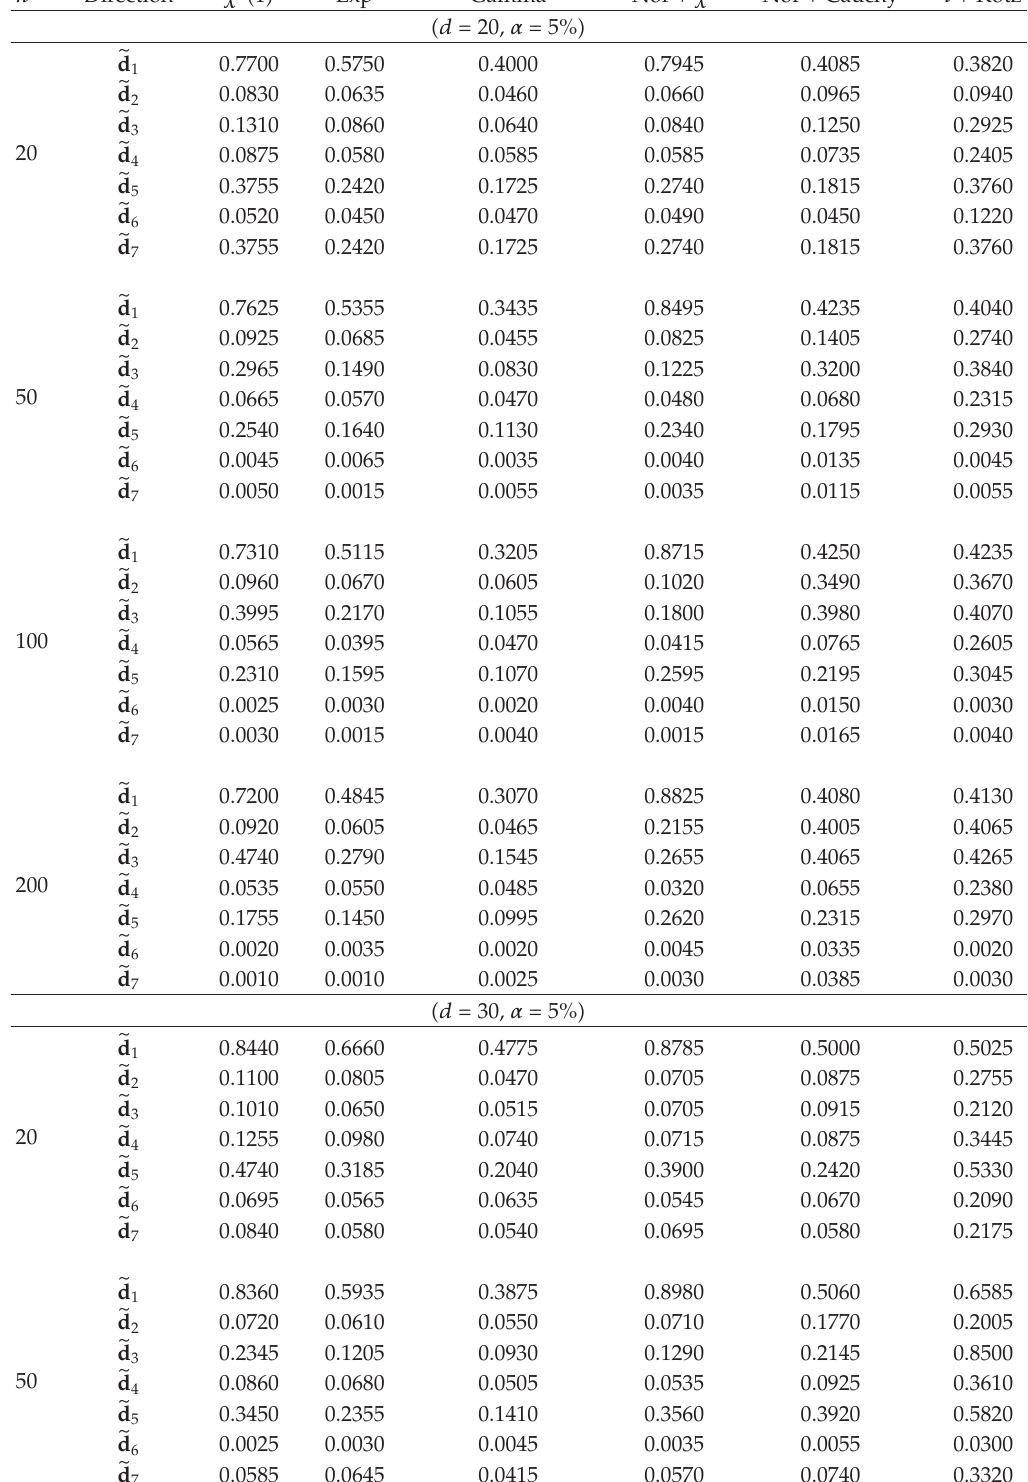
Table 2: Power of the ST 3 -plot in testing spherical symmetry for six nonspherical distributions.